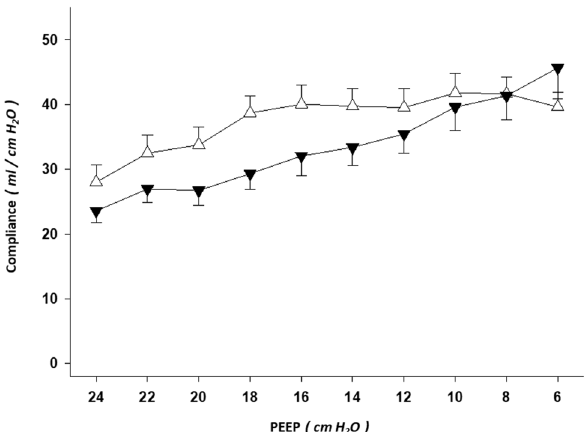
Figure 3. Respiratory system compliance in supine vs. prone body position. Line graphs of the respiratory system compliance from forty-two decremental positive end-expiratory pressure (PEEP) titrations—supine vs. prone body position—are shown (mean ± SEM). Triangle up (white): supine body position. Triangle down (black): prone body position. X axis: decremental PEEP levels of the EIT-PEEP titrations. Y axis: respiratory system